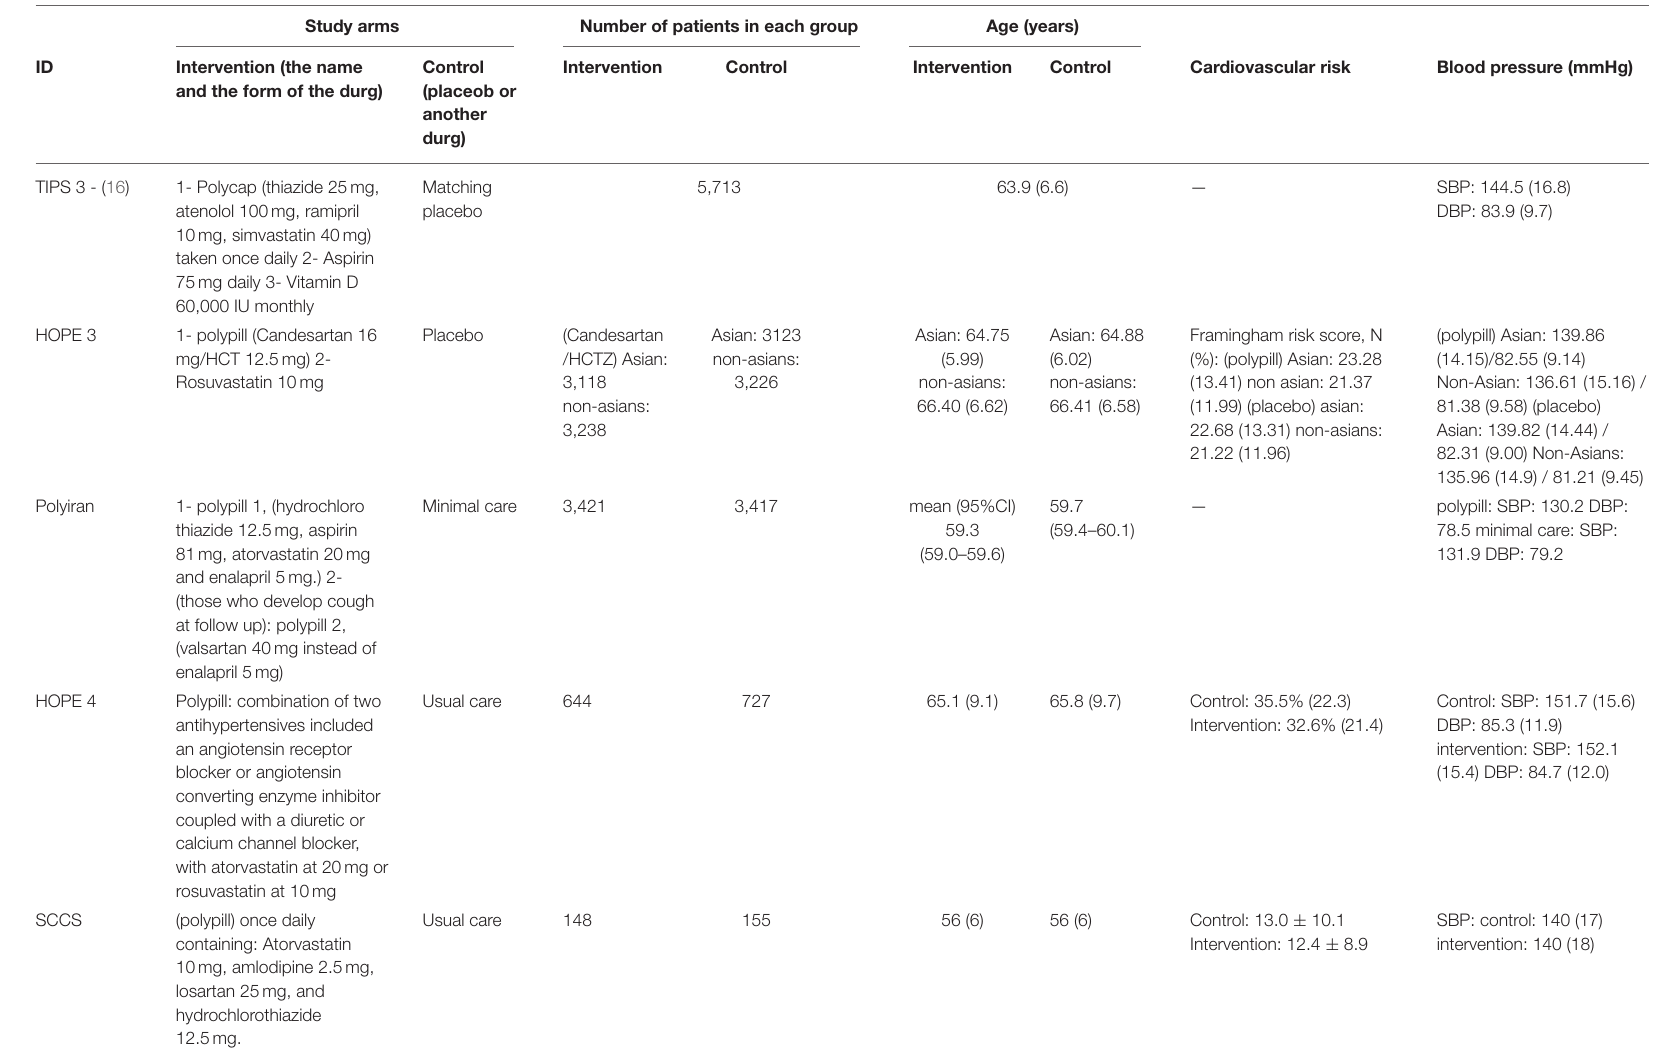
TABLE 3 | Baseline characteristics of patients